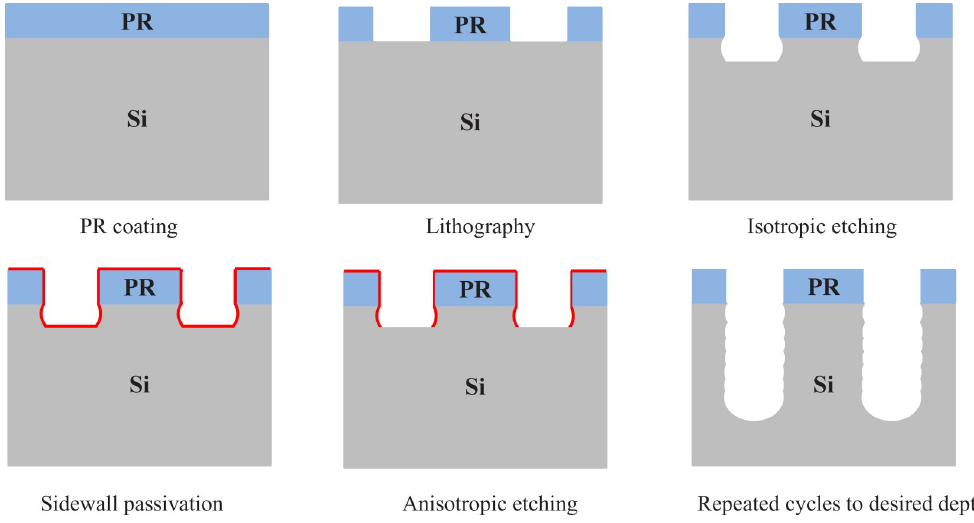
Fig 7. Illustration of the trenching in the Bosch etching process